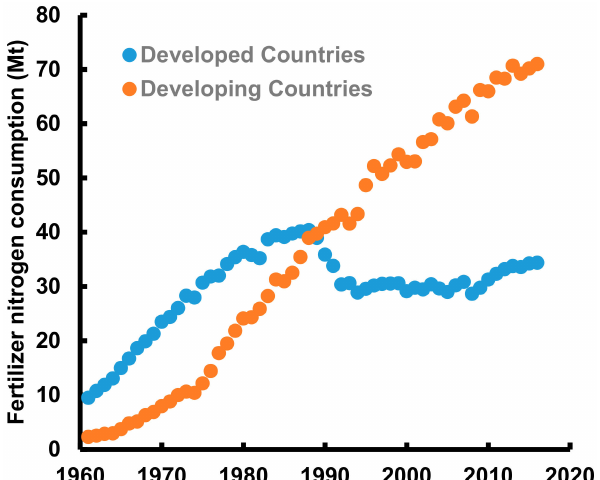
Figure 1. Total fertilizer nitrogen consumption in developed and developing countries since the 1960s. Data source: